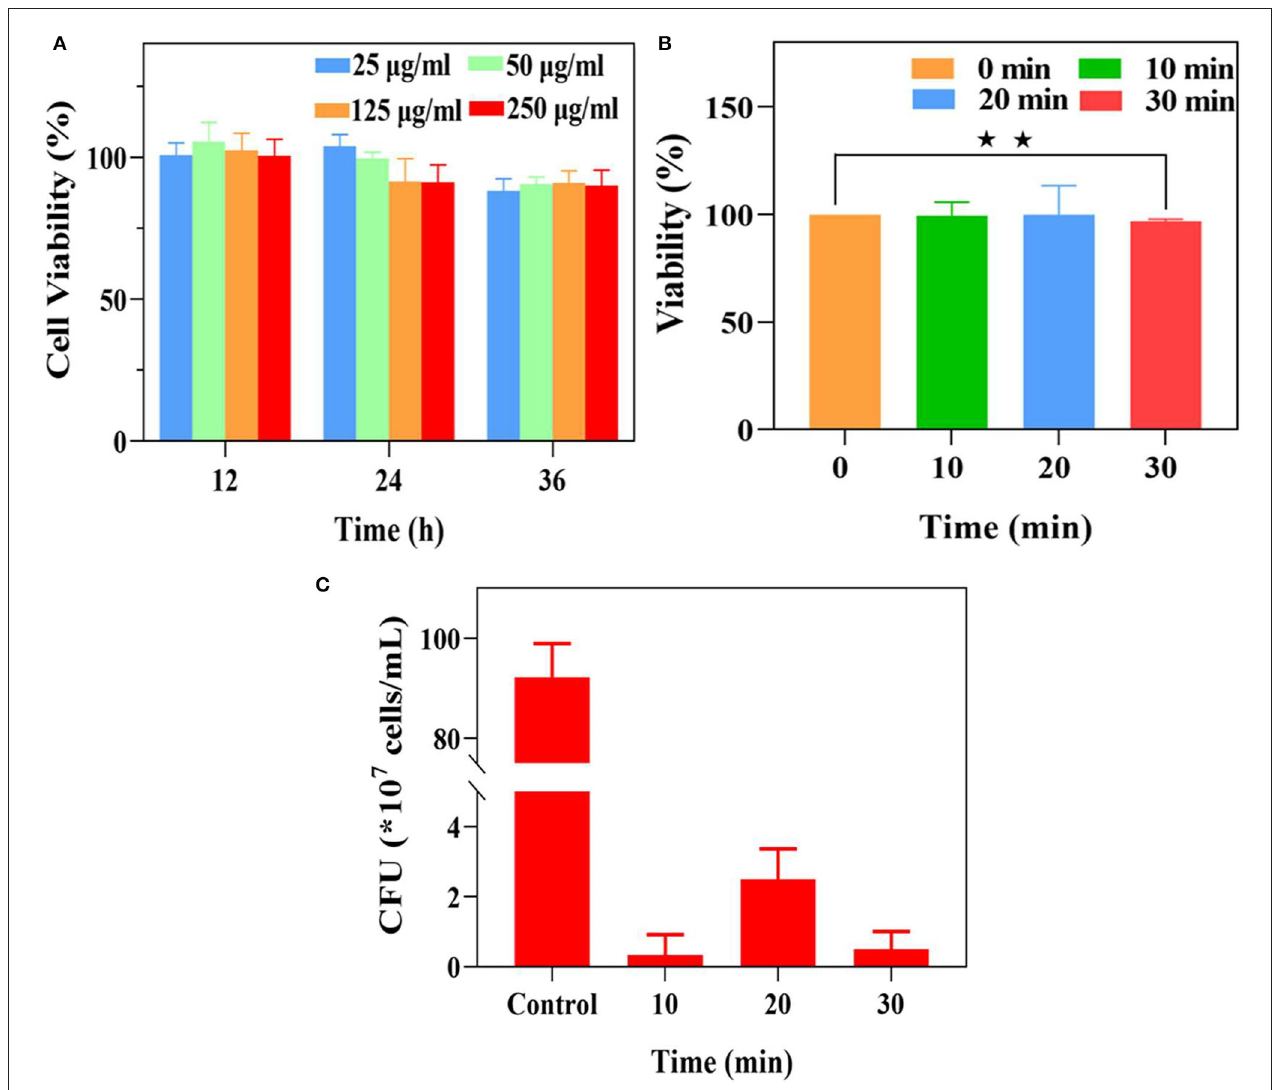
FIGURE 4 | (A) The cell viability of L929 fibroblasts with different concentrations of UCNP@SiO 2 /MB@QCh for 12, 24, and 36h. (B) The viability of E. faecalis after different irradiation times. (C) The residual CFU of E. faecalis was treated with UCNP@SiO 2 /MB@QCh after different irradiation times. * p < 0.05, ** p <